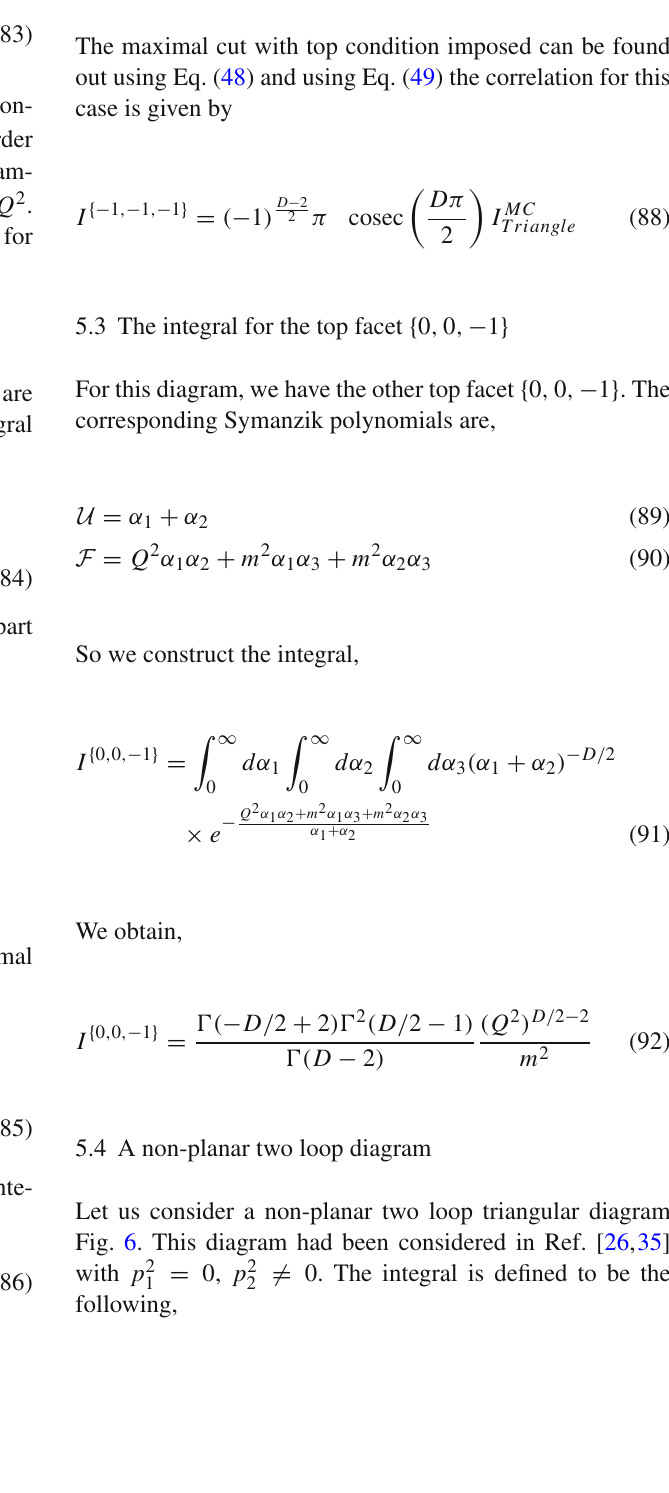
Fig. 5 Maximal cut of the triangular